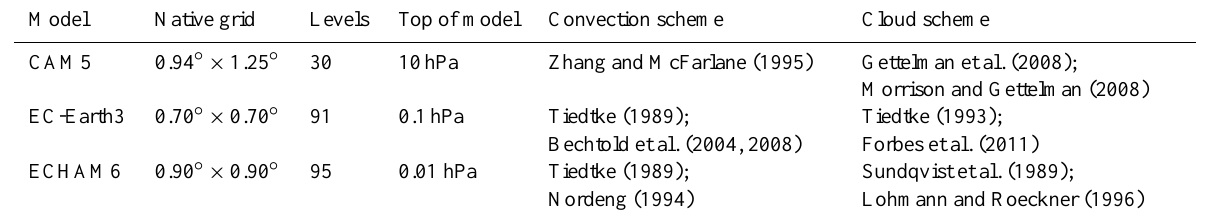
Table 2. Some basic information about each model.